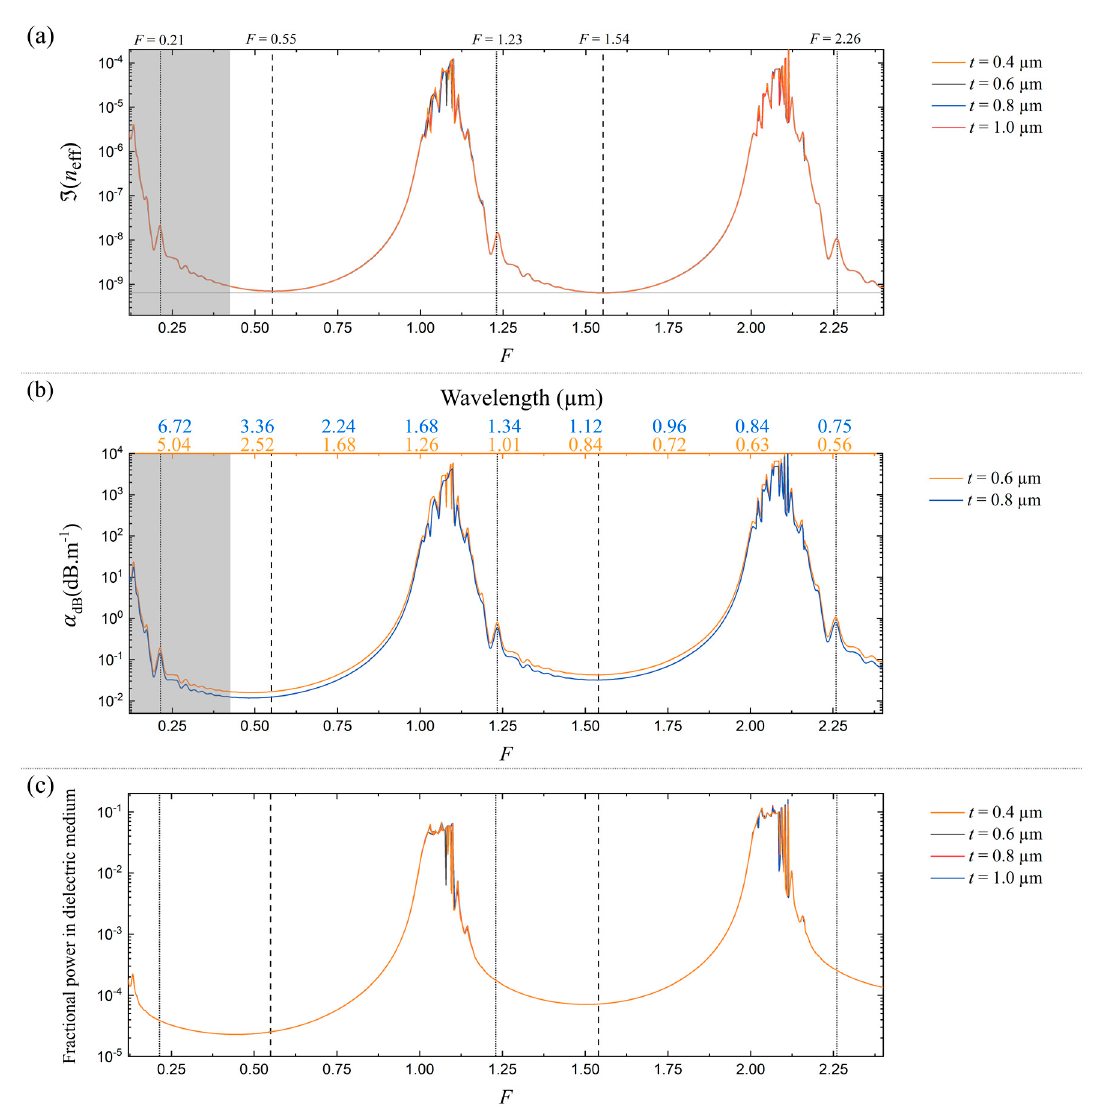
Figure 3. ( a ) Imaginary part of the fundamental core mode index, (cid:61) ( n eff ) , as a function of F in a six-tube THCF when G = 25 and d / D = 0.65. The calculation is carried out for four different t values, 0.4, 0.6, 0.8, and 1 µ m, to illustrate the scalability of the results. ( b ) Corresponding confinement loss versus wavelengths when t = 0.6 and 0.8 µ m. Gray-shaded regions in ( a , b ) mark the long wavelength region, e.g., wavelength longer than 3.15 µ m when t = 0.6 µ m. ( c ) Fractional optical power in the dielectric medium in the same